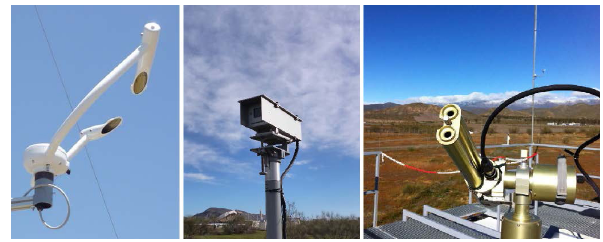
Figure 1. Left: scatterometer Vaisala FS11, center: long-path trans- missometer Optec LPV4, right: sun photometer